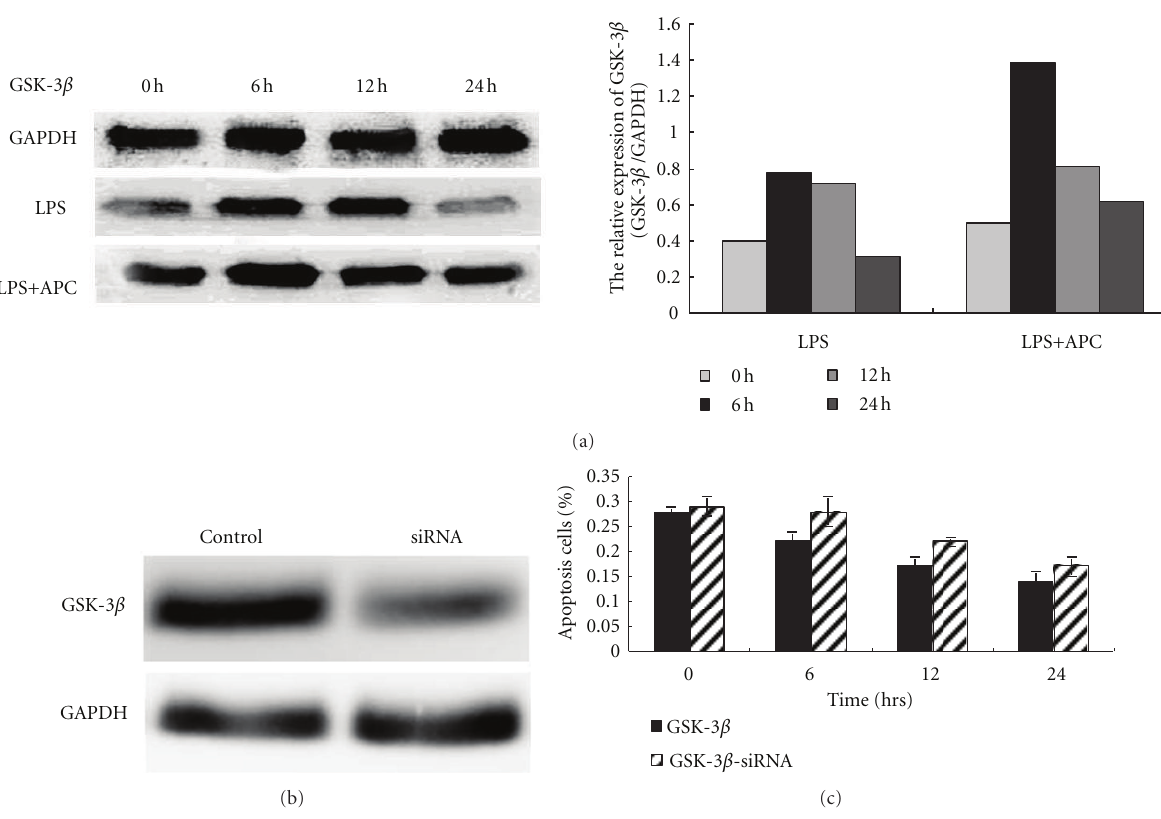
Figure 4: Upregulation of GSK-3 β expression following APC treatment and decreased antiapoptotic activity following GSK-3 β -siRNA transfection of HUVECs. HUVECs exposed to 10ng/mL LPS for 24 h, were treated with 150nM APC for 0, 6, 12, and 24h. Upregulated GSK- 3 β expression was detected, peaking at 6h after APC treatment (a). Transfection of HUVECs with GSK-3 β -siRNA decreased the abundance of GSK-3 β protein significantly (b). Compared with normal HUVECs treated with 150 nM APC, a significant increase of the percentage of apoptosis cells was found in HUVECs pretreated with GSK-3 β -siRNA (GSK-3 β versus GSK-3 β -siRNA, P < 0 . 05), indicating that the antiapoptotic activity of APC was inhibited by GSK-3 β -siRNA